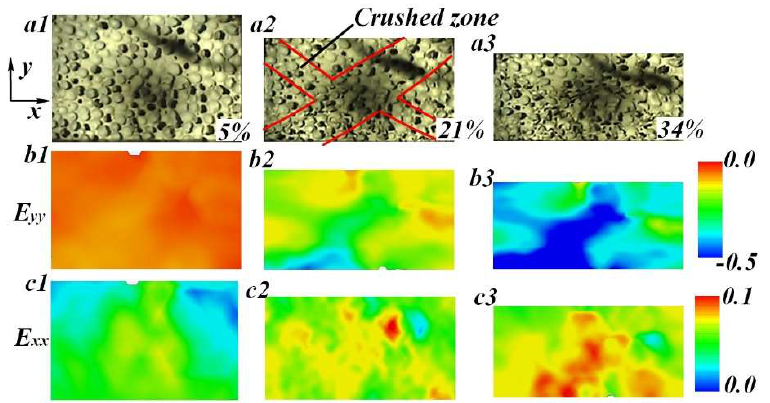
Figure 11. ( a ) Typical deformation behavior and ( b – c ) strain fields of TC specimen under drop-weight